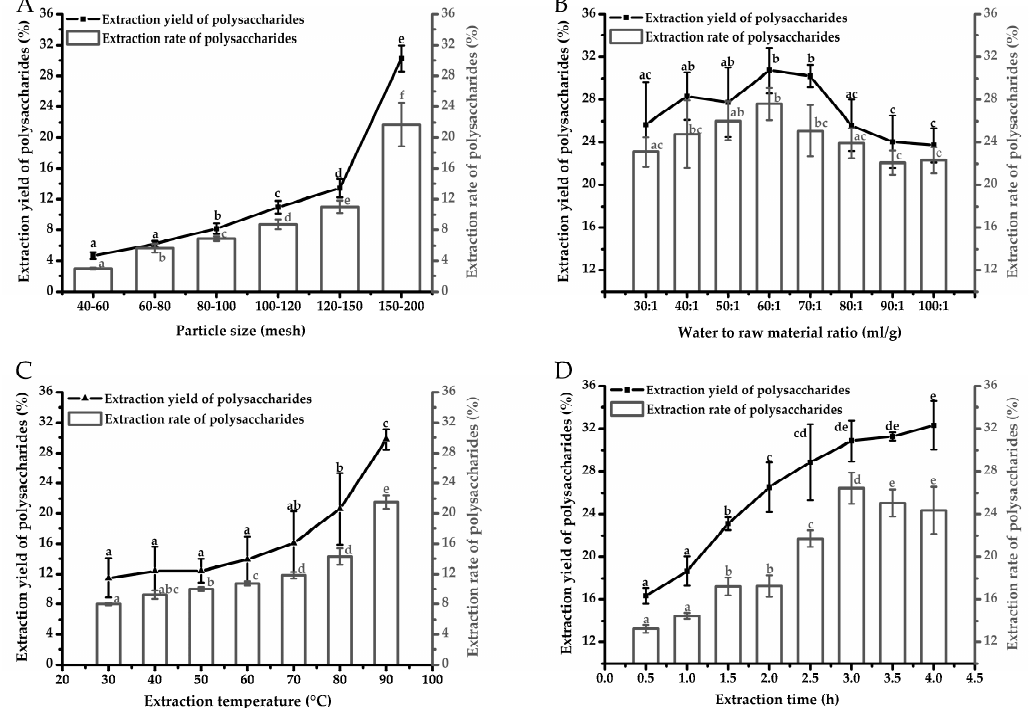
Figure 2. Effects of single-factor ( A ) particle size, ( B ) water to raw material ratio, ( C ) extraction temperature, ( D ) extraction time by hot water extraction on extraction yield and extraction rate of polysaccharides from Auricularia cornea var. Li. Values with different letters are significantly different ( P < 0.05) for extraction yield and extraction rate of polysaccharides.